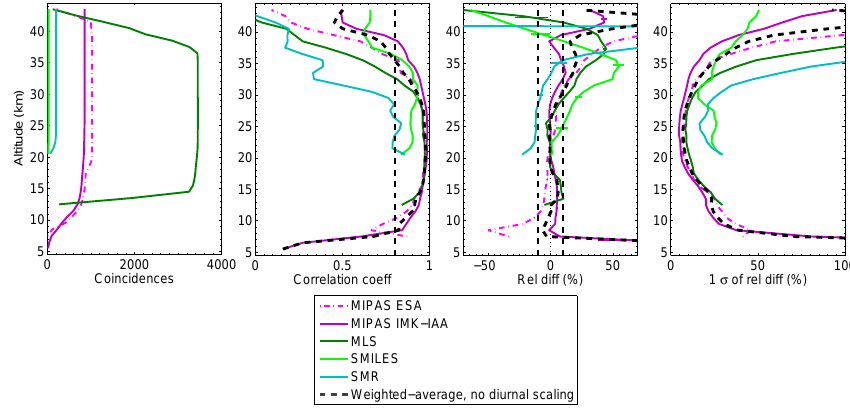
Figure 11. Same as top panel of Fig. 7 (comparisons with no diurnal scaling) except for HNO 3 , with coincidence criteria of within 6h and 100km. Error bars in the relative difference profiles represent the standard error of the mean (values less than ∼ 1% may not be visible).